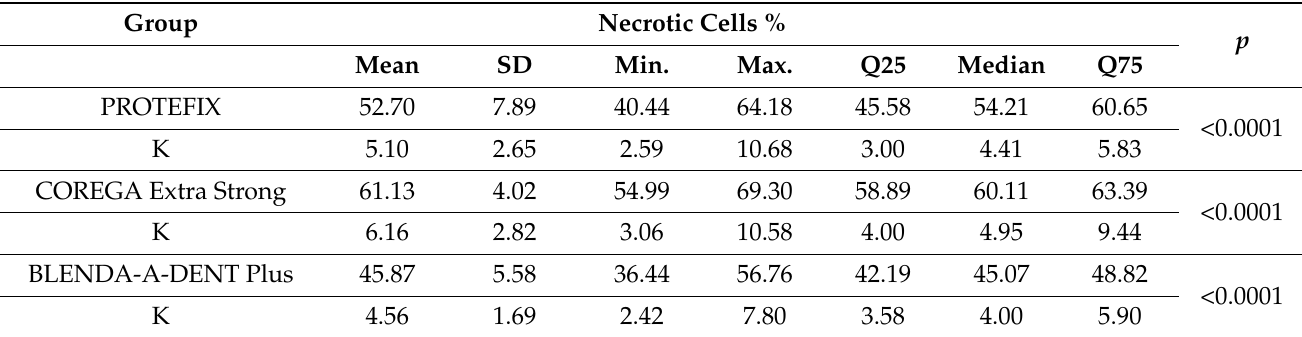
Table 2. Descriptive statistic for the value of necrotic fibroblasts and differences between study and control groups analyzed using Mann-Whitney test.